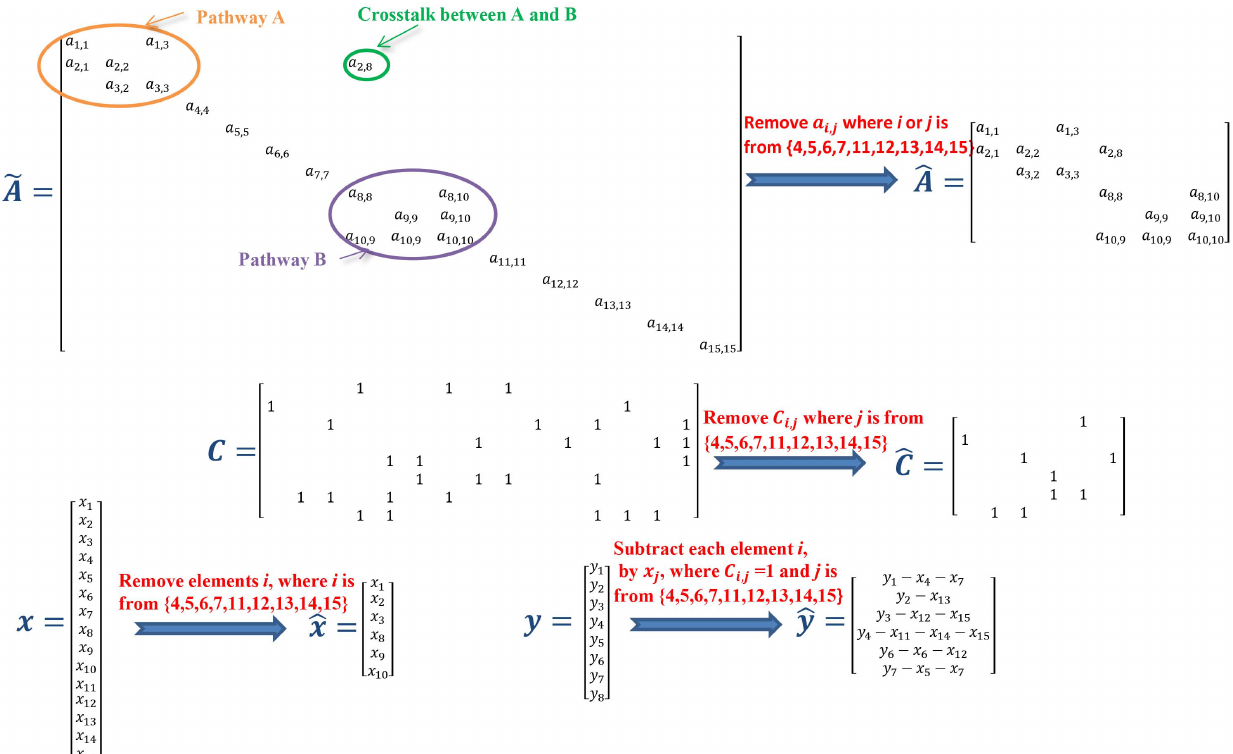
Figure 2. The process of refinement. The equations at the left and right side of arrows are original and reduced respectively. According to inferred transition matrix ~ AA , there are two pathway and crosstalk between them. The 4 th , 5 th , 6 th , 7 th , 11 th , 12 th , 13 th , 14 th , 15 th species are silent, having no links with others. All elements associated with the silent species are removed from the transition matrix A to form the refined transition matrix ^ AA . All columns measuring the silent species are deleted from the measurement matrix C to form the refined measurement matrix ^ CC . The refined concentration vector, ^ xx , only keeps the concentrations of active species (e.g., 1 th , 2 th , 3 th , 8 th , 9 th , 10 th ). An element of the refined observation vector ^ yy is equal to the corresponding element of the observation vector y subtracted by the concentrations of the silent species involved in this measurement. If all species involved in a measurement are silent, simply remove this measurement.